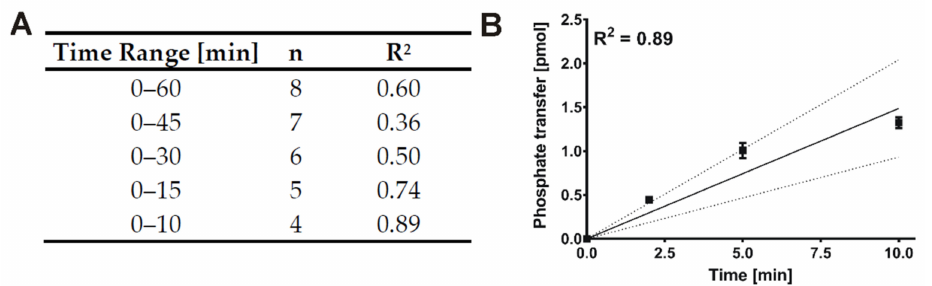
Figure 6. Determination of initial velocity linear region for 6 × His-CK1 δ . ( A ) In order to determine the maximum coefficient of determination (R 2 ) linear regression analysis was conducted with step- wise decreasing the number of included time points of the product-over-time progression curve determined for 6 × His-CK1 δ (70 nM). ( B ) Linear regression for the determined initial velocity re- gion (10 min) including R 2 value and confidence bands (95%). n, sample size; R 2 , coefficient of determination.